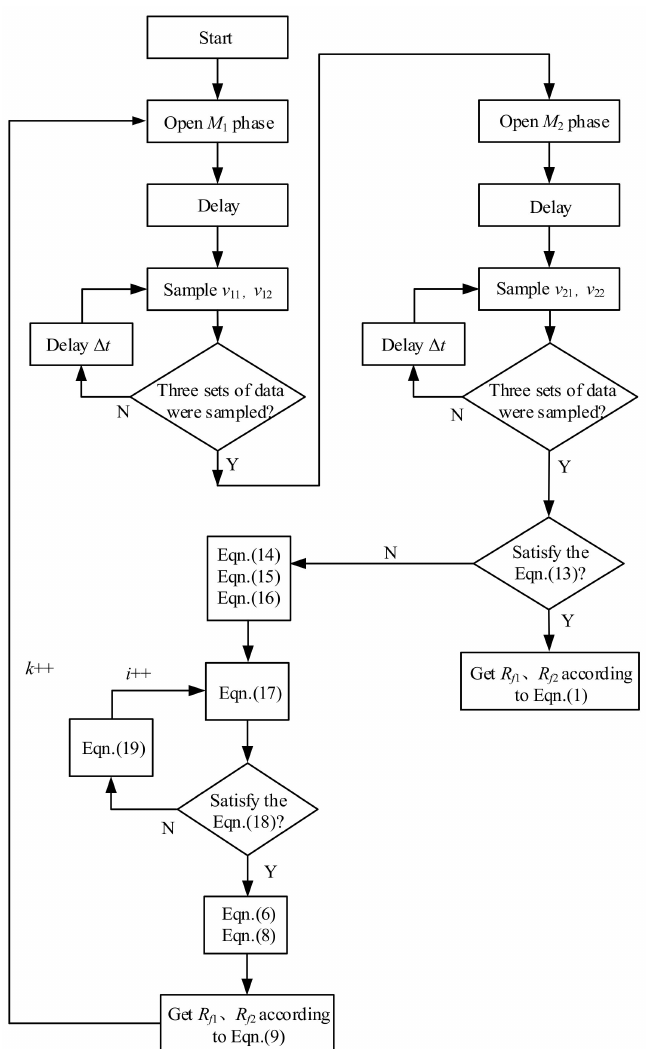
Figure 7. Software flow chart of the proposed